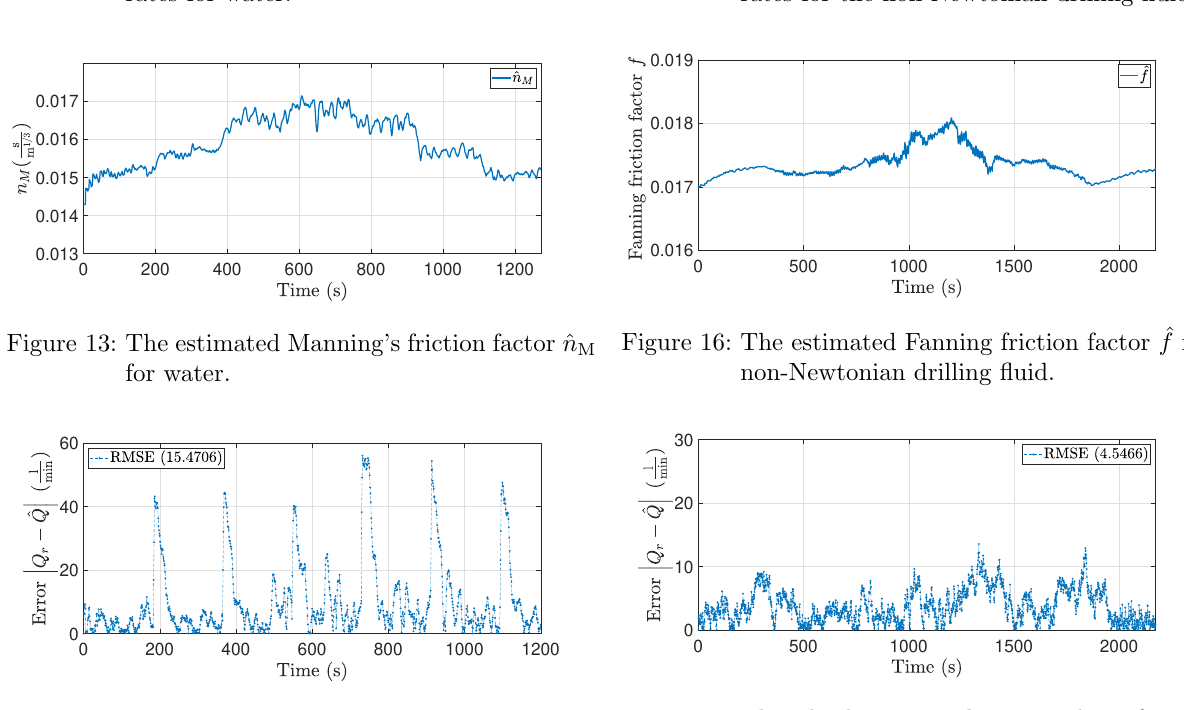
Figure 14: The absolute error between the reference Q r and estimated ˆ Q flow rates for water.